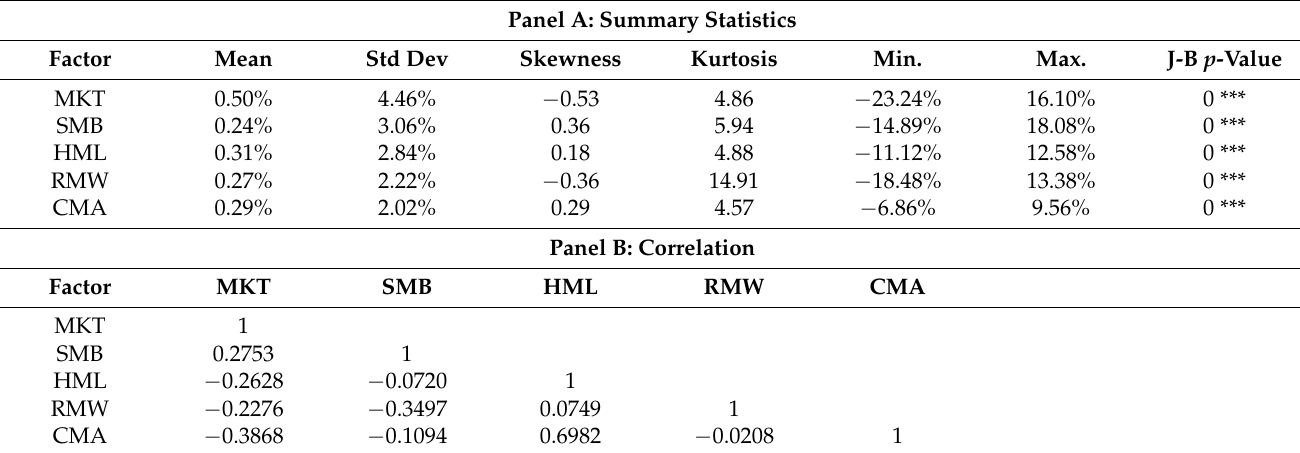
Table 1. Summary statistics and correlation of the five factors. Panel A: Summary